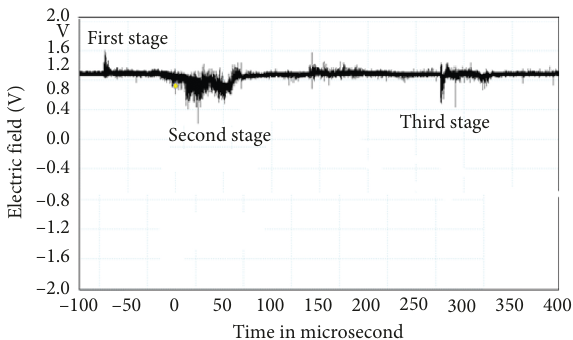
Figure 8: An example of the electric field due to a typical cloud flash having three stages.